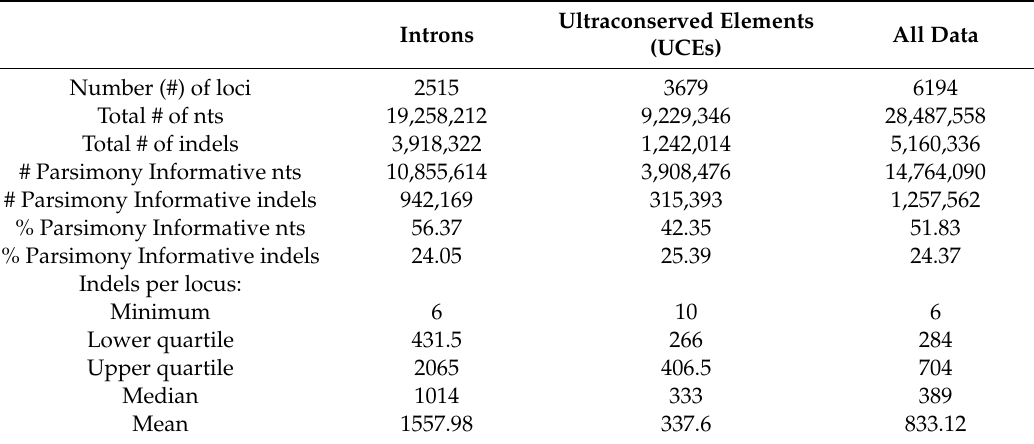
Table 1. Indel and nt information